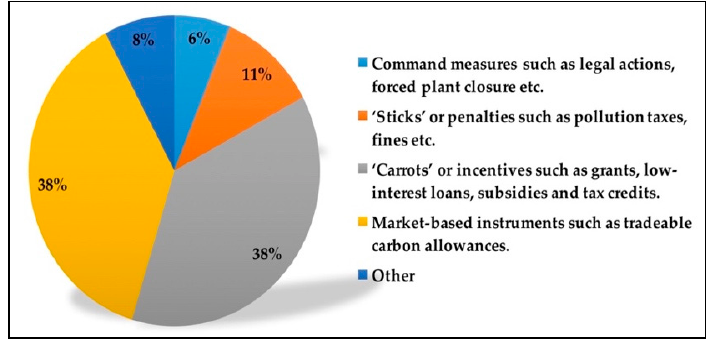
Figure 9. Stakeholder preferences for policy mechanisms to support CCUS steel projects.